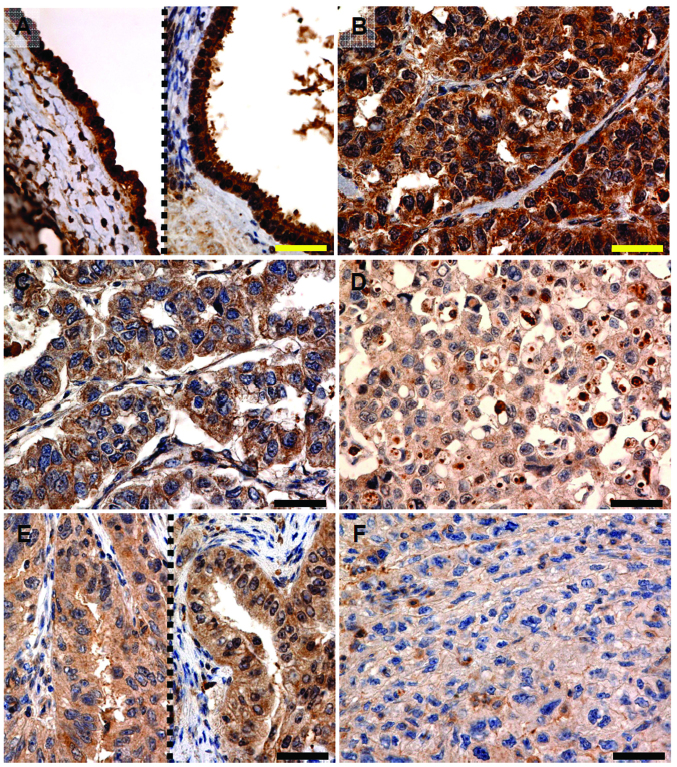
Representative CYP27B1 immunostaining in normal epithelium (of surface and follicle) (A), primary adenocarcinoma of grade G1 (B), G2 (C) and G3 (D) and metastases of grade G2 (E) and G3 (F). Scale bars, 50 μm.